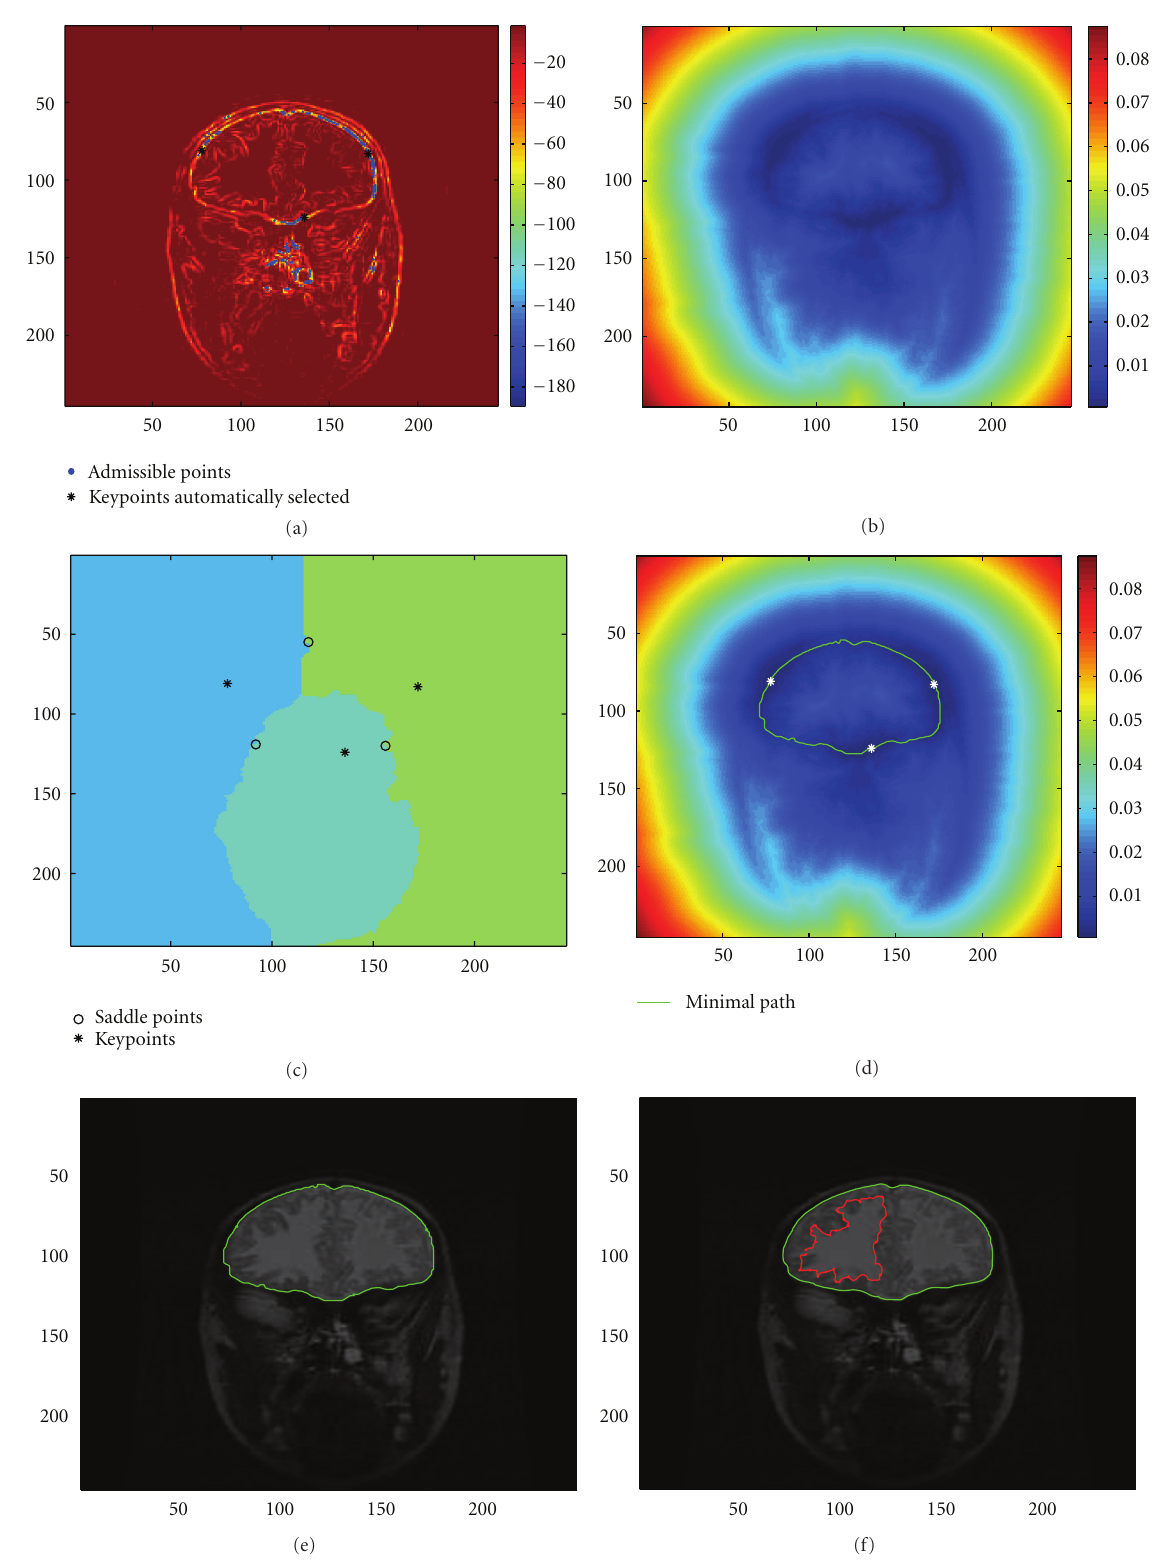
Figure 6: (a) Admissible set of points (i.e., most negative values of the topological gradient) in blue, and 3 keypoints automatically selected in black; (b) Distance function computed from these 3 keypoints with the fast marching algorithm; (c) Corresponding Vorono¨ı diagram, with the 3 keypoints and saddle points; (d) Identified minimal path between the keypoints represented on the distance function; (e) Minimal path between the keypoints represented on the original image; (f) Another identified continuous contour from other